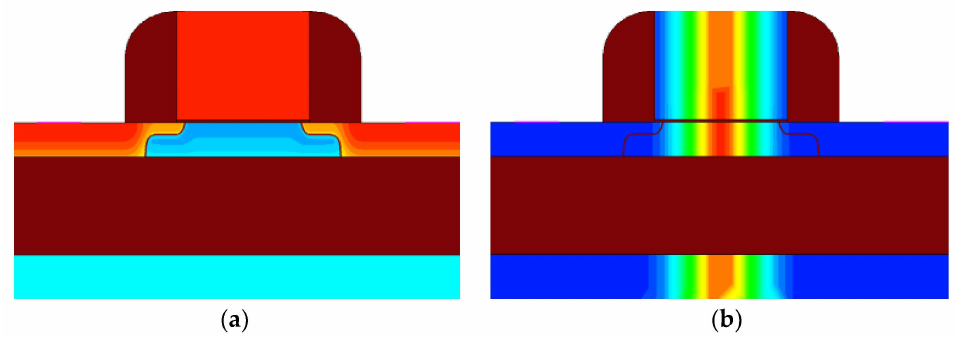
Figure 1. ( a ) Structure of FDSOI in the simulation and ( b ) track profile of the heavy